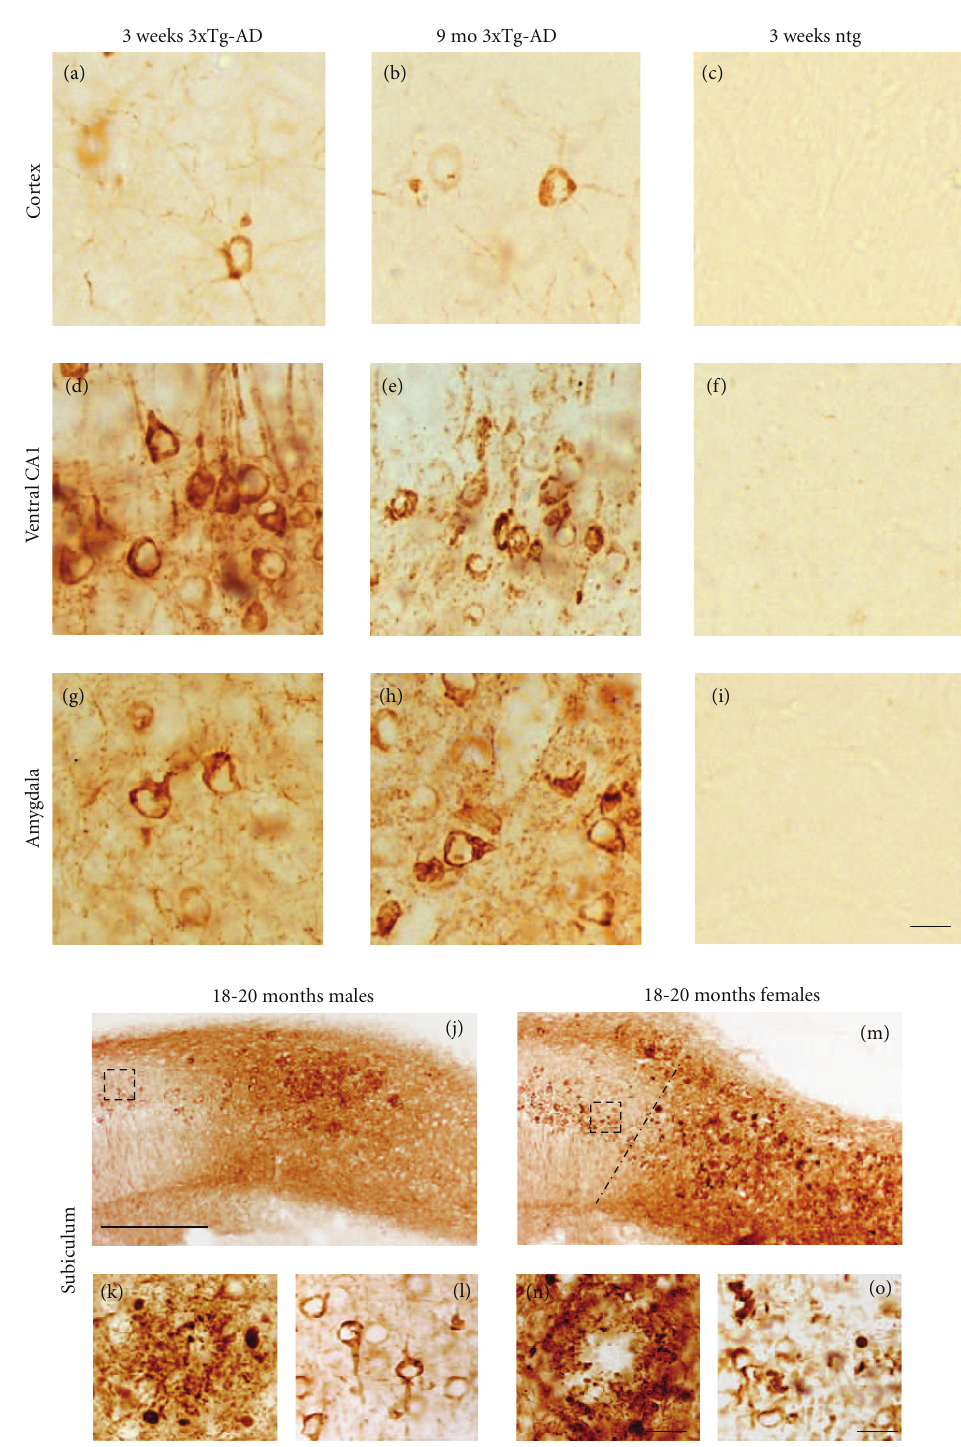
Figure 5: Photomicrographs of Alz50-ir neurons in 3-week, 9- and 18-20-month-old 3xTg-AD mice. At 3 weeks of age scattered neurons were found in the frontal parietal cortex (a) and BLA (g), whereas numerous Alz50-ir ventral hippocampal pyramidal cells were labeled (d). By 9 months of age, neurons in the BLA and ventral hippocampus appeared shrunken (e) compared to the cortex (b). Numerous Alz50-ir plaques and dystrophic neurites were found in the male ((j)-(k)) and female subiculum ((m)-(n)). Dashed boxes show higher magnification images of dystrophic Alz50-ir CA1 pyramidal neurons ((l), (o)). Dashed line in panel (m) demarks the CA1 field from the subiculum. Ntg mice failed to show Alz50 immunoreactivity ((c), (f), (i)). Scale bar in ((a)–(i)); ((k), (l), (o)) = 20 μ m, ((j), (m)) = 100 μ m, and (n) = 30 μ